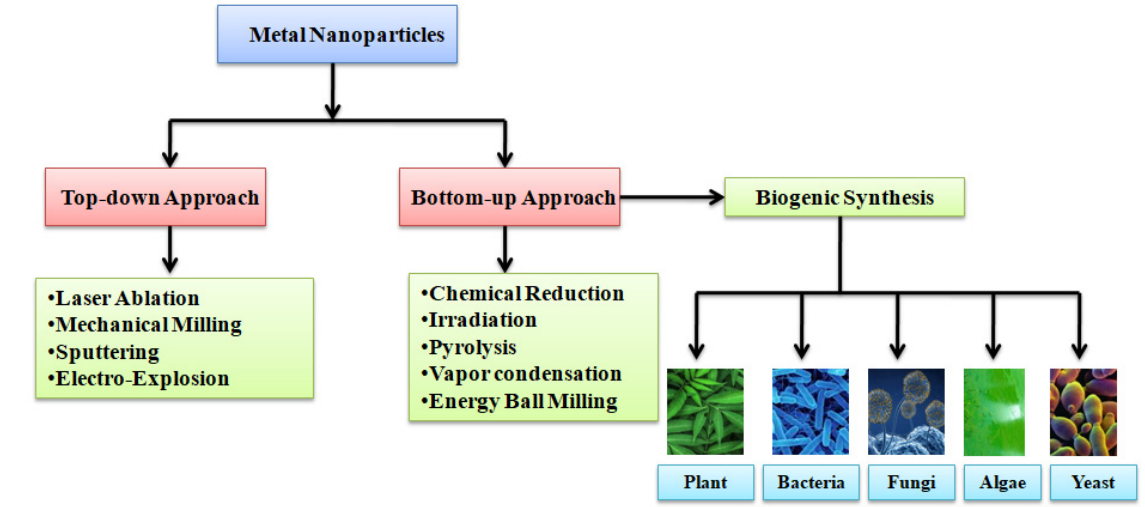
Figure 1. Synthesis of metal nanoparticles. Table 1. Important physical, chemical, and photochemical methods used for the synthesis and stabilization of AgNPs